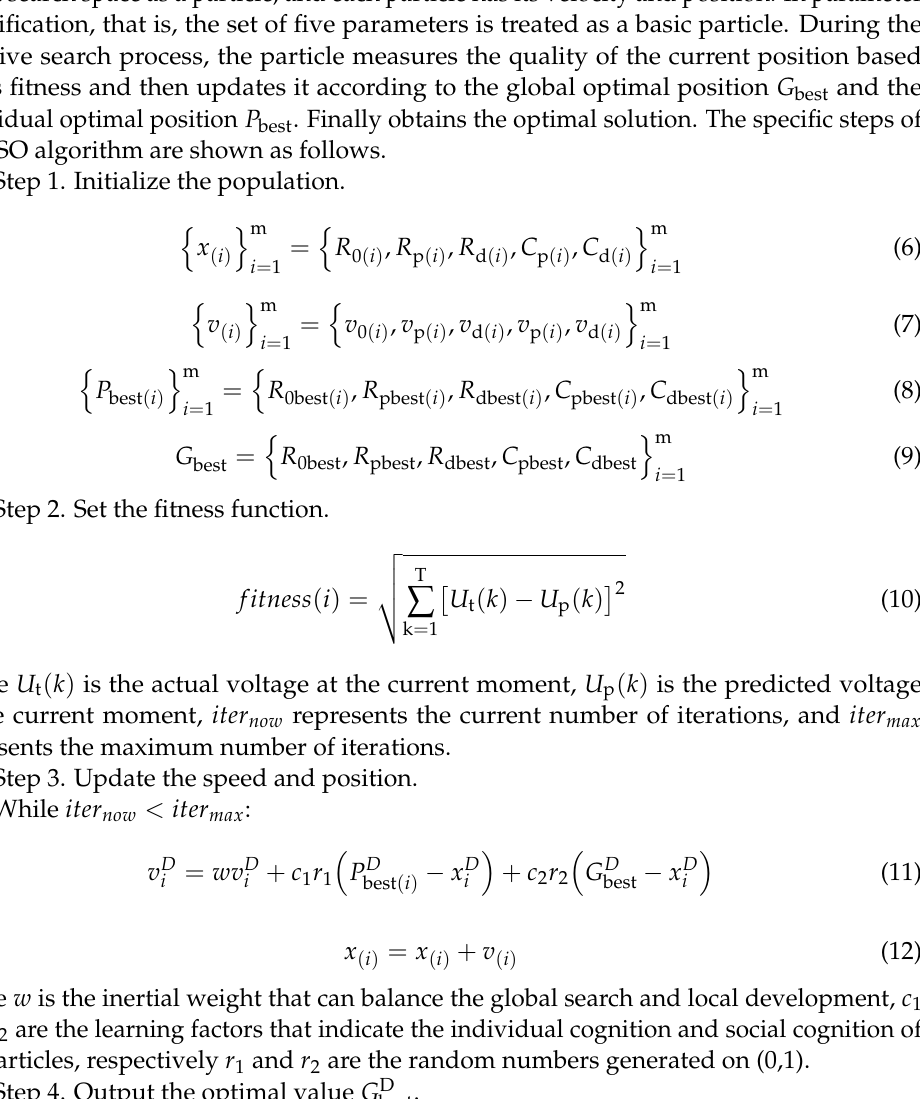
Figure 3. Voltage of Incremental Current Condition.